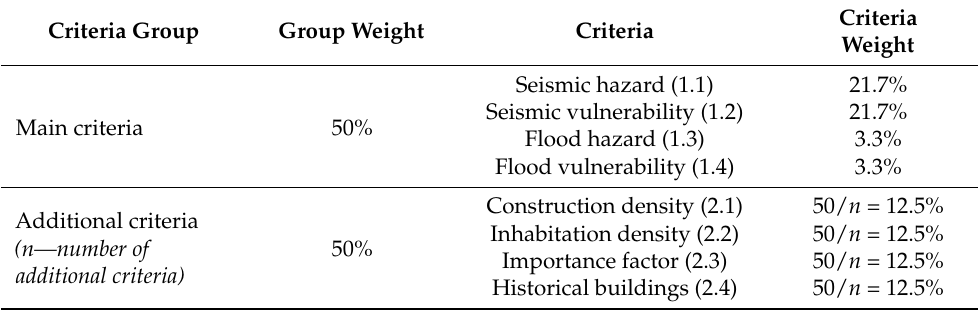
Table 4. An example of criteria weights for combined seismic-flood risk for Scenario S-F Level 2.